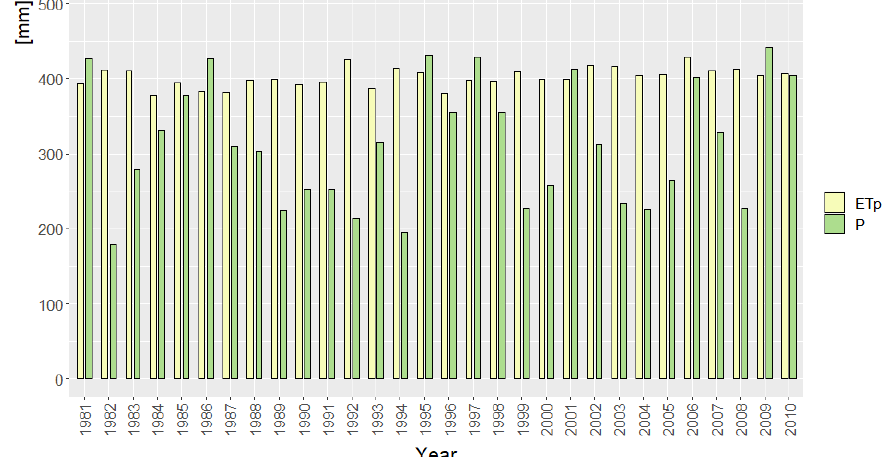
Figure 4. Precipitation ( P ) and water needs (ETp) in the growing season (third decade of May— October) in 1981–2010 in the Lubusz voivodeship (SD of P = 93, SD of ETp = 17.4). Among the analyzed regions, Lower Silesian voivodship had the highest number of vegetation seasons in which precipitation exceeded water needs. In this case, positive values were recorded in 6 out of 30 years, more precisely in 1981, 1986, 1995, 1997, 2001, and 2009 (Figure 5). The year 1981 was also in this region characterized by the lowest precipitation in the vegetation season, amounting to 179 mm. It was also the year when the difference between precipitation and ETp was the greatest and amounted to 233 mm. A relatively large difference (220 mm) was re-recorded in 1994. The highest precipitation values were reached in 1997 with 522 mm. For the 30 years analyzed, the SD of precipitation was 85.7, while for water needs, the SD was 12.6 (Table 2).